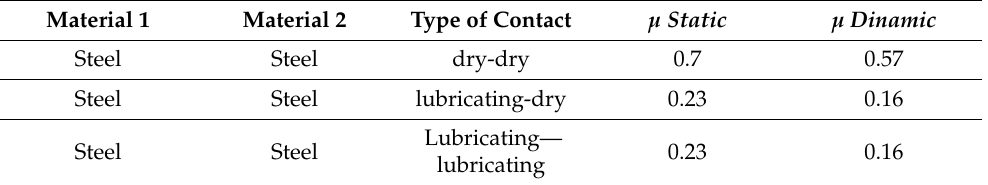
Table 1. Static and dynamic coefficients of friction.